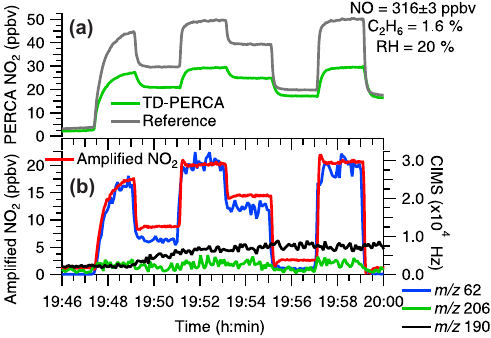
Figure 8. Scatter plots of TD-PERCA-CRDS and CIMS mea- Figure 7. (a) Sample time series of PNA observed by TD-PERCA- surements. (a) Sample PNA calibrations at an NO mixing ra- CRDS in the reference, NO 2 channel (shown in green), and PERCA tio of 316 ± 3ppbv and TD-PERCA inlet temperature of 120 ◦ C. channel (grey). (b) (left) Difference signal between amplified and For mixing ratios<0.6ppbv, the intercept and slope of the linear reference channel (shown in red). (right) CIMS counts (normalized fits are (0.2 ± 0.1)ppbv and 26.3 ± 0.4 ( r 2 = 0 . 979) at RH = 20% to 10 6 I − ) at m/z 62, the major fragment (NO − ) expected from 3 and (0.3 ± 0.1)ppbv and 18.0 ± 0.2 ( r 2 = 0 . 985) at RH = 75%. PNA; at m/z 206 (multiplied by a factor of 100 for clarity), the (cid:113) (cid:113) (b) Sample PAN calibration at a NO mixing ratio of 662 ± 2 ppbv HNO 4 I − cluster; and at m/z 190, the HNO 3 I − cluster. and TD-PERCA inlet temperature of 250 ◦ C and RH = 20%. The intercept and slope of the linear fit is ( − 0.13 ± 0.09)ppbv and 36.0 ± 0.4 ( r 2 = 0 . The difference between these two signals is displayed in Fig. 7b (red trace, left-hand axis). Superimposed in Fig. 7b (right-hand axis) are the CIMS responses at m/z 62 (NO − ), 3 (cid:113) m/z 206 (HNO 4 I − , multiplied by a factor of 100 for clar- (cid:113) ity), and m/z 190 (HNO 3 I − ).